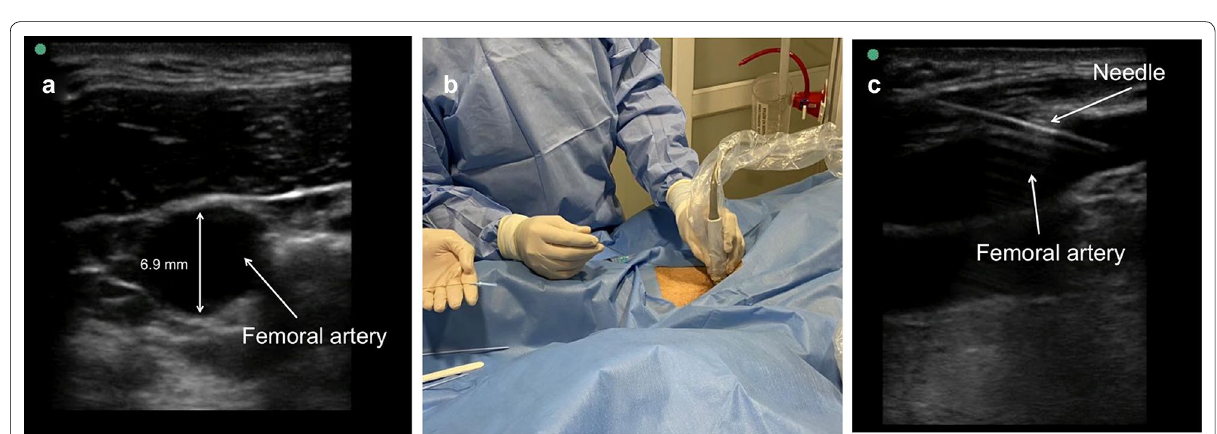
Fig. 2 a Short-axis visualization of the femoral artery with a high-frequency linear transducer 6.9 mm in diameter. b Puncture under direct visualization. c Long-axis visualization of the femoral artery as the needle enters the femoral artery during